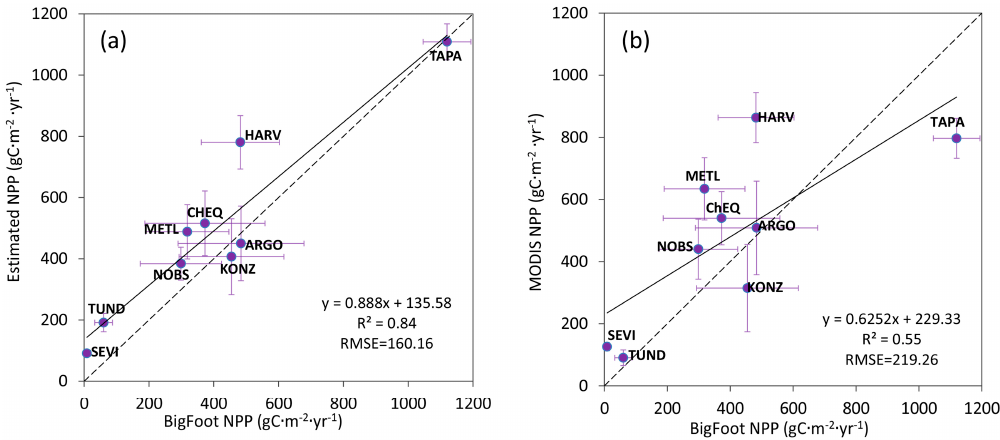
Figure 12. Validation of estimated GLASS NPP and MODIS NPP against BigFoot NPP: ( a ) validation of estimated GLASS NPP against BigFoot NPP; ( b ) validation of MODIS NPP against BigFoot NPP. x is the average of BigFoot NPP, the years being averaged are shown in Table 1; y is the average of NPP in 2004, 2008 and 2012.